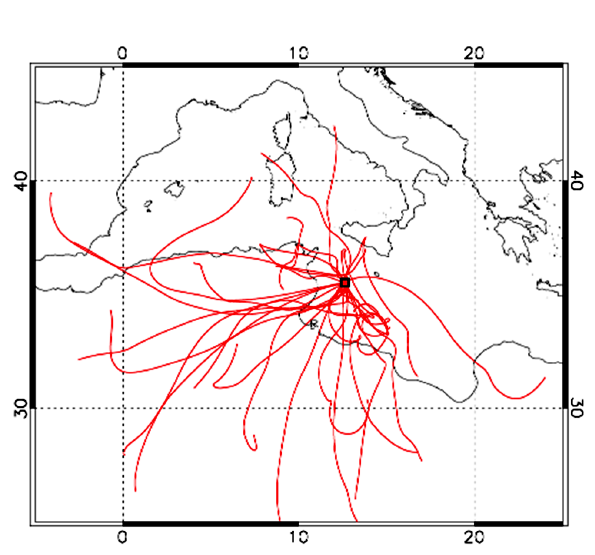
Figure 5. HYSPLIT backward trajectories ending at Lampedusa at 50ma.s.l. corresponding to the peaks in the PM 10 contributions due to mineral dust source (see text for the